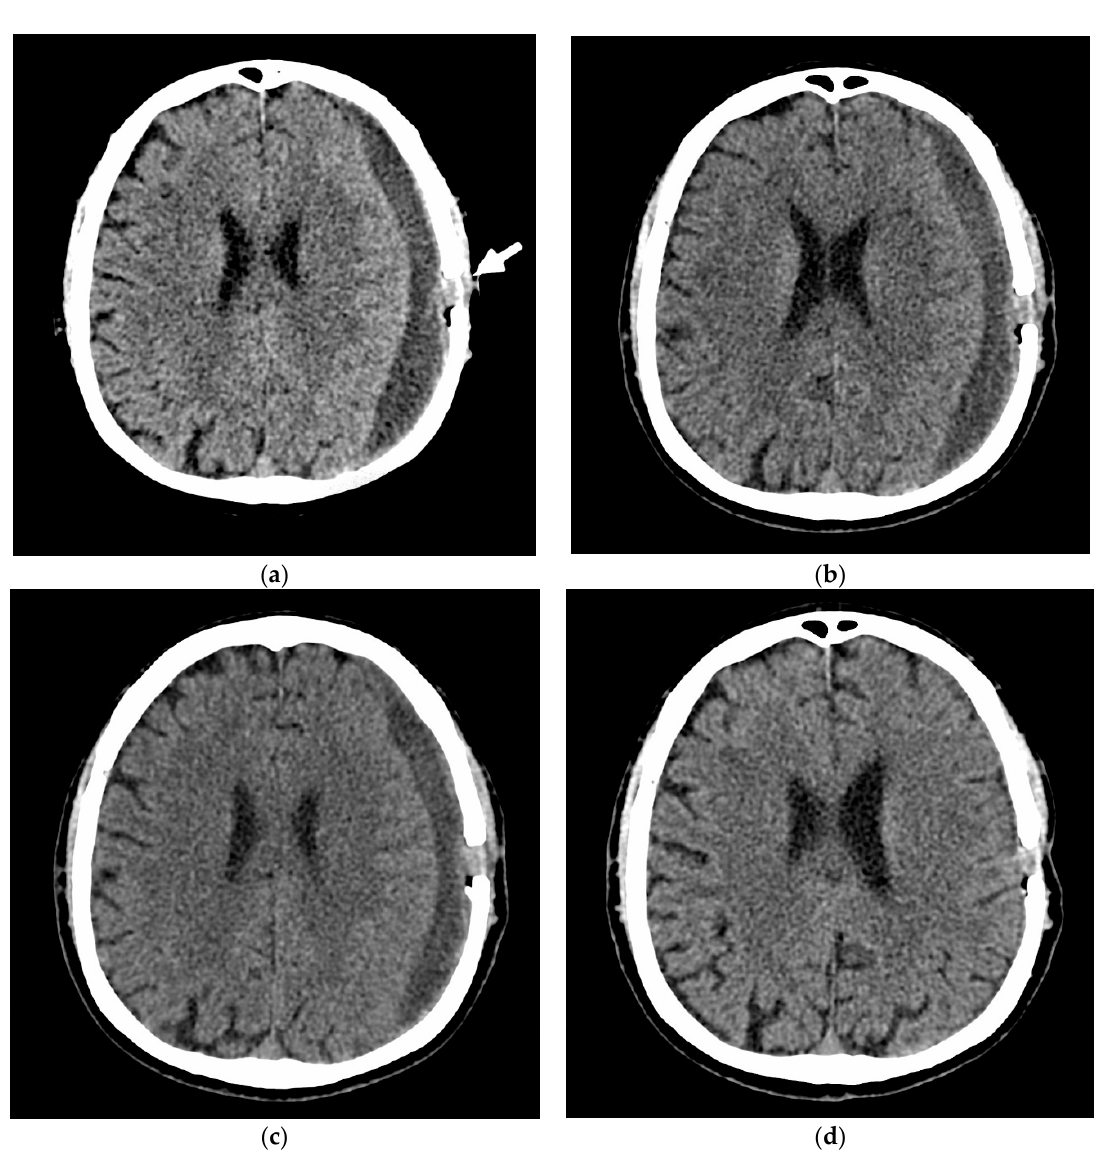
Figure 4. NCCT 28 days after surgical evacuation of a CSDH with recurrence and before embolization of the ipsilateral MMA ( a ). Four days ( b ) and 8 days ( c) after the embolization, the CSDH is already seen to be shrinking. Four months after the embolization ( d ), the CSDH has entirely been resolved.